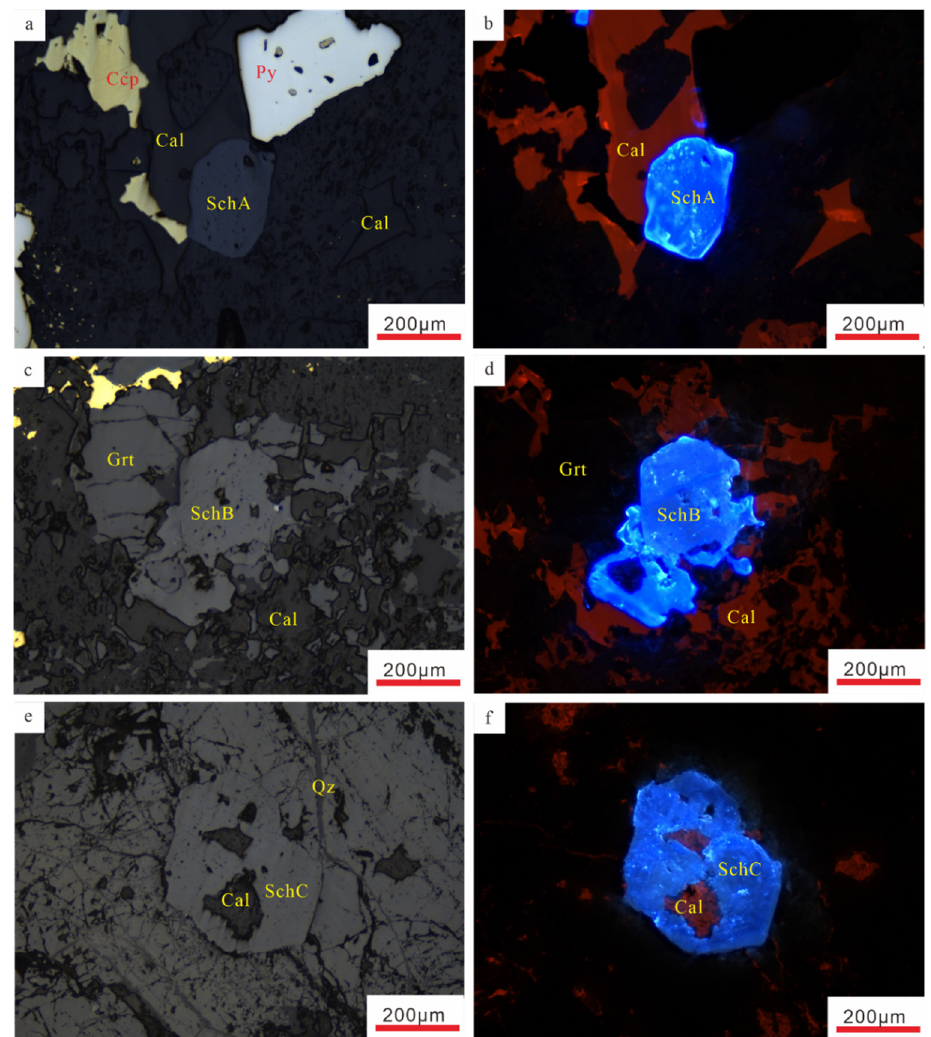
Figure 5. ( a , b ): SchA is paragenetic with later sulfide minerals, e.g., chalcopyrite; ( c , d ): SchB occurs with early garnet and sulfides under reflected light microscope in image “c”, and has some lighter part and fractured edge in OM-CL image “d”; ( e , f ): SchC mainly coexists with garnet and is obviously filled in and traversed by calcite and quartz. Abbreviations: Sch-scheelite, Grt—garnet, Cal—calcite, Qz—quartz, Ccp—chalcopyrite, Py—pyrite. The images on the left are under the microscope with reflected light, and the right images are OM-CL